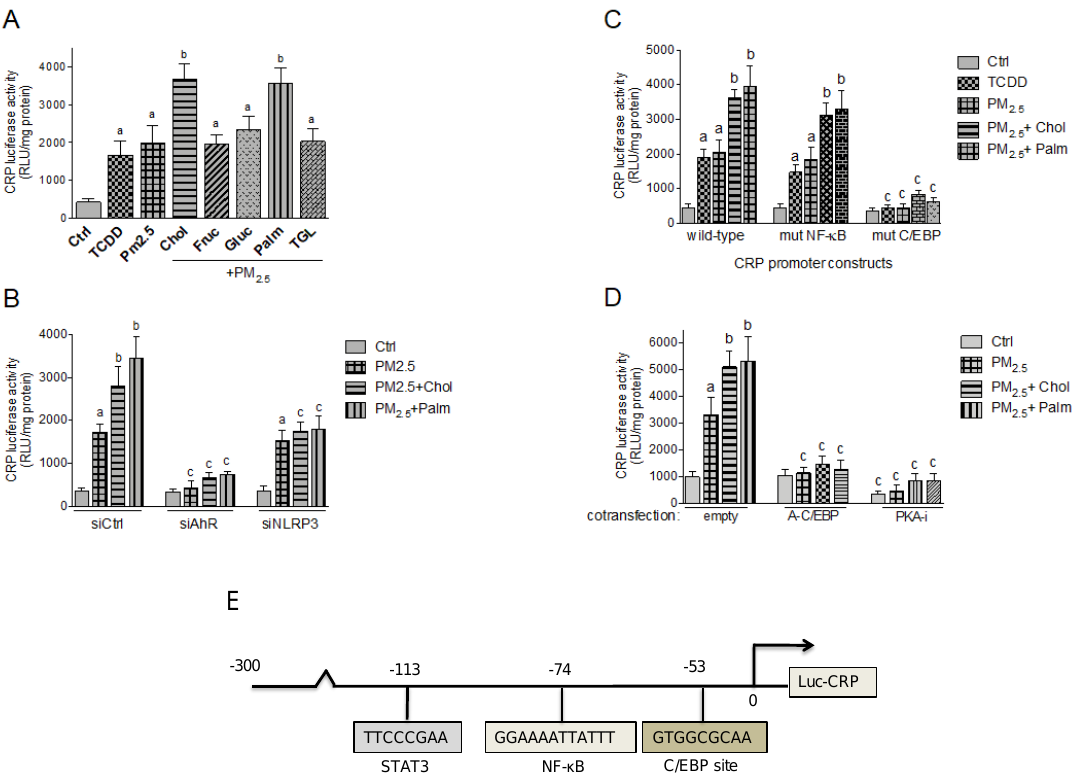
Figure 6. E ff ect of nutritional compounds on PM 2.5 -induced CRP promoter activity. ( A ) Umac were transiently transfected with a luciferase promoter construct containing 300 bp upstream of the regulatory sequence of the human CRP gene promoter. After 24 h cells were treated with 1 nM TCDD and 10 µ g / mL PM 2.5 in presence or absence of nutritional factors cholesterol (Chol, 10 µ g / mL), fructose (Fruc, 25 mM), glucose (Gluc, 25 mM), palmitic acid (Palm, 5 µ M), and triglyceride (TGL, 10 µ g / mL) for 6 h. Control cells were treated with the corresponding vehicle only. ( B ) Umac were transiently transfected with the CRP wt luciferase promoter construct and co-transfected with a scrambled control siRNA, a AHR-specific or NLRP3-specific siRNA. After 24 h cells were treated with 10 µ g / mL PM 2.5 in the presence or absence of cholesterol (Chol, 10 µ g / mL) or palmitic acid (Palm, 5 µ M). ( C ) Umac were transiently transfected with the luciferase reporter constructs of the wt CRP promoter or a CRP construct containing a mutation in the NF-kB (mut NF-kB) or C / EBP binding site (mut C / EBP). After 24 h cells were treated with 1 nM TCDD or 10 µ g / mL PM 2.5 in the presence or absence of cholesterol (Chol, 10 µ g / mL) or palmitic acid (Palm, 5 µ M). ( D ) PM 2.5 -induced CRP promoter activity is C / EBP- and PKA-dependent. Cells were co-transfected with an empty, C / EBP-A dominant negative expression plasmid, or a PKA inhibitor (PKA-i) expression plasmid for 24 h and treated with 10 µ g / mL PM 2.5 in presence or absence of cholesterol (Chol, 10 µ g / mL) or palmitic acid (Palm, 5 µ M) for 6h. Relative luciferase activity units (RLU) are given as mean values of triplicates as a result of three independent experiments. a significantly higher than control ( p < 0.05); b significantly higher than cells treated with PM 2.5 only ( p < 0.05); c significantly lower than cells transfected with ctrl siRNA, wild-type CRP, or an empty vector (p < 0.05). ( E ) Schematic illustration of the promoter construct of the human CRP gene containing 300 bp upstream of the transcriptional start site (indicated by an arrow) cloned into a luciferase (luc) reporter vector. Positions of the C / EBP, NF- κ B, and STAT3 recognition sites are